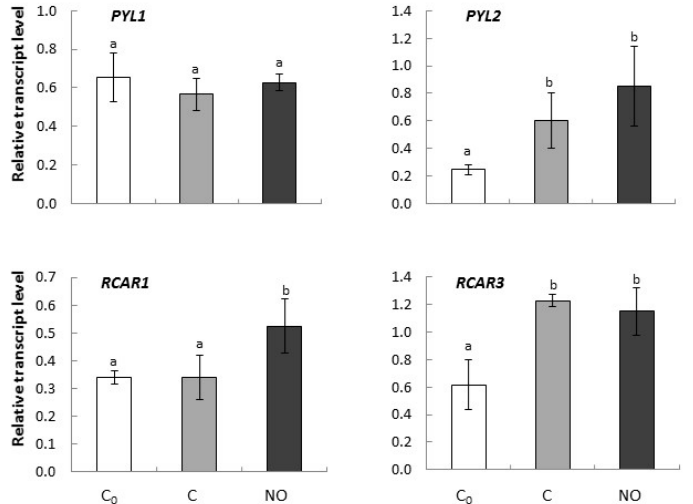
Figure 2. The relative expression level of genes encoding ABA co-receptors ( PYL1 , PYL2 and RCAR1 , RCAR3 ) in axes of apple embryos isolated after 24 h of seeds imbibition in water (C 0 ), in axes of embryos imbibed in water for 3 h after seed coat removal (C), in axes of embryos fumigated with NO for 3 h (NO). The expression of genes was normalized to UBI as a reference gene. Two technical replicates were performed for each four biological replicates. Error bars represent ±SD; a, b homogenous groups. RCAR1 was significantly up-regulated by NO treatment in comparison to both controls. The transcript level of this gene did not differ in axes of dormant, non-treated embryos (C 0 and C) (Figure